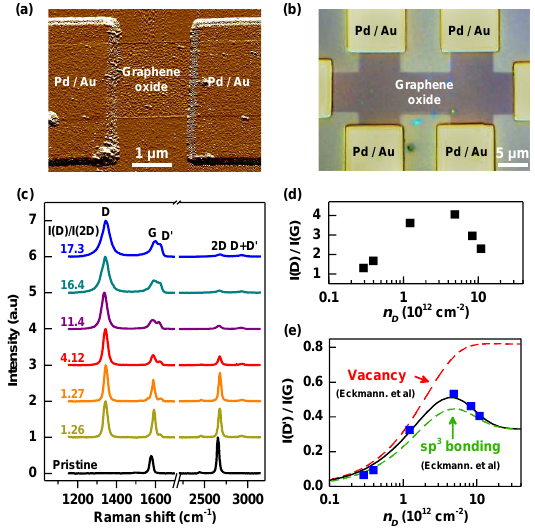
Figure 1. ( a ) Atomic force microscope image of a typical graphene FET, irradiated with UV for oxidation. ( b ) Optical image of a CVD-grown graphene device with Hall-bar geometry. ( c ) The evolution of Raman spectra of graphene devices exposed to UV light arranged according to the value of I ( D ) / I ( 2 D ) . ( d ) Values of n D deduced from I ( D ) / I ( G ) for six graphene devices irradiated with UV ( e ) I ( D (cid:48) ) / I ( G ) as a function of n D . The black solid line is a fit to Equation (2). Dashed lines are the evolution of I ( D (cid:48) ) / I ( G ) either for vacancies or sp 3 sites, suggested from Ref.